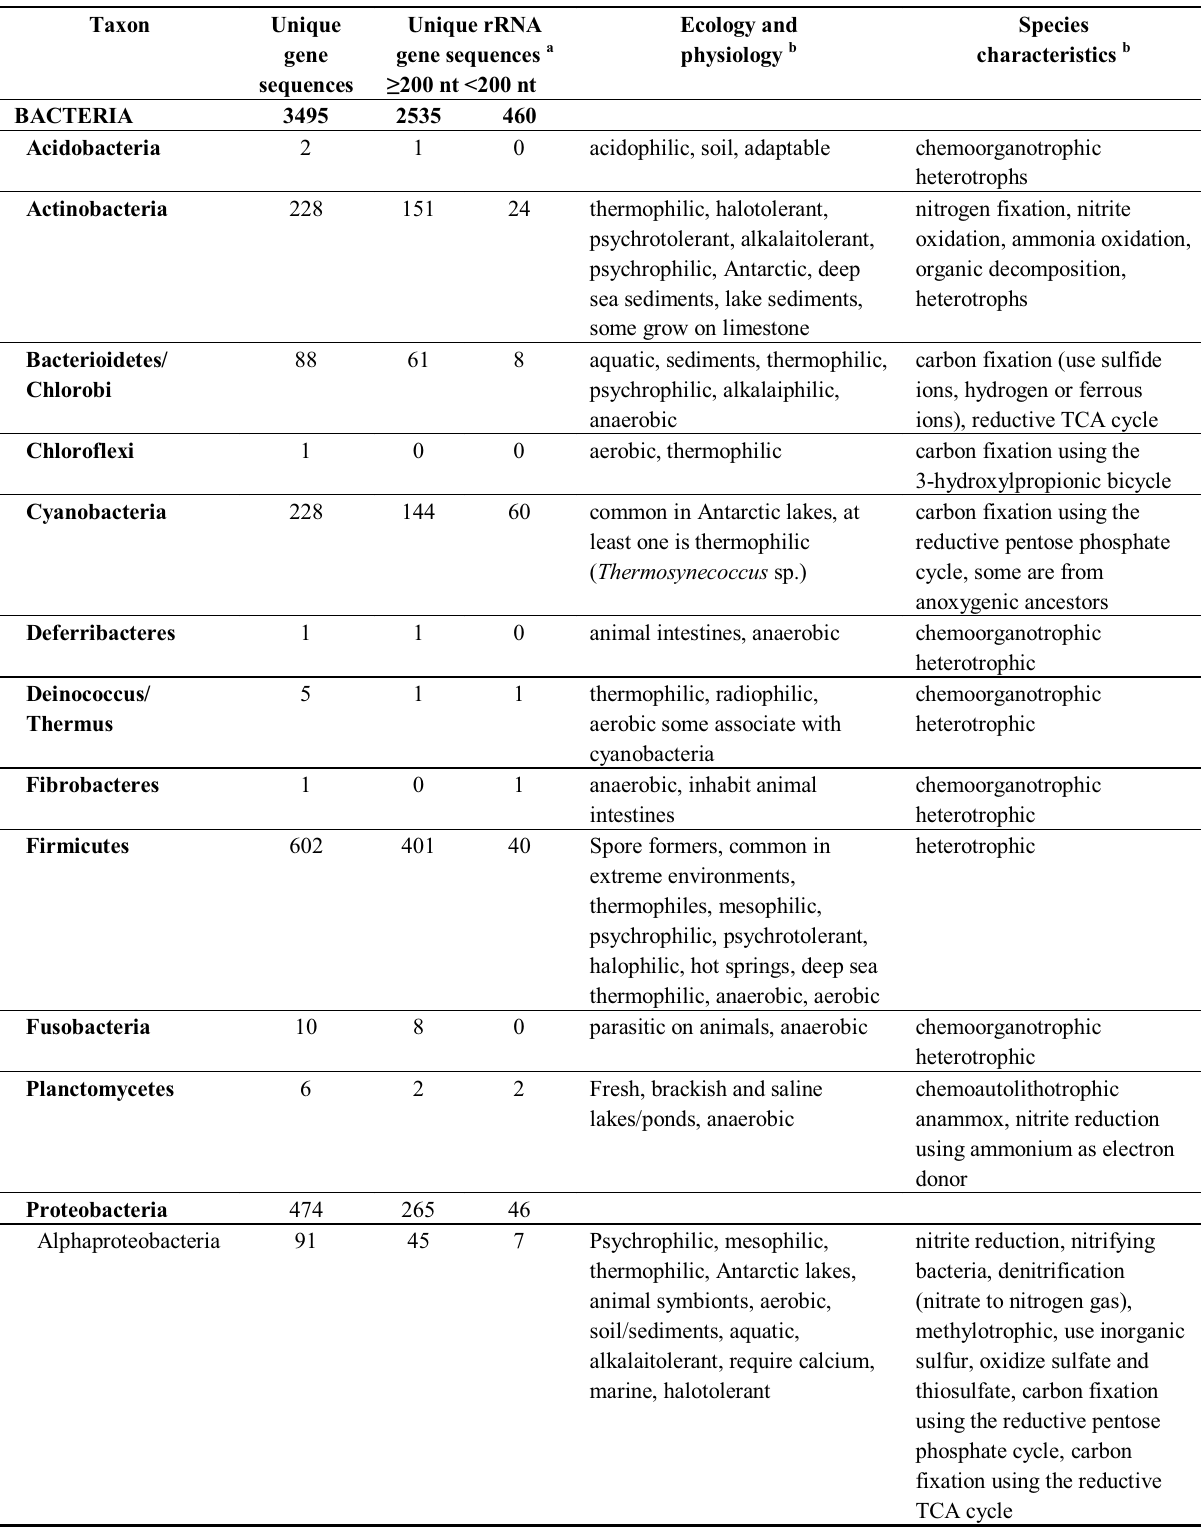
Table 1. Summary of sequence results for V5 (total of 1,863; or 3,718, including sequences that cannot be classified to species). The number of sequences in each taxon, ecology/physiology of each classified taxon and species characteristics are presented. Sequences are grouped by Domain and